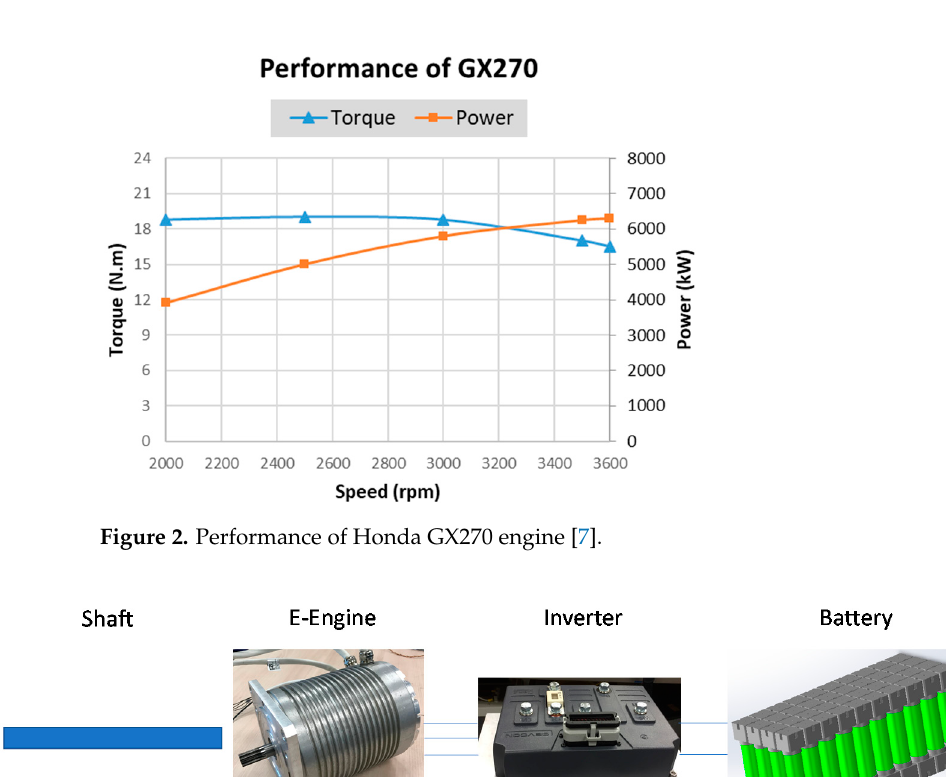
Figure 3. E-propulsion architecture. Figure 3.